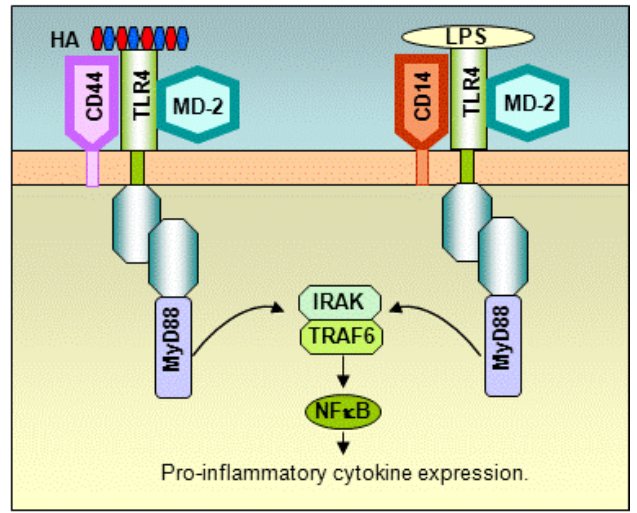
FIGURE 3. Comparable TLR4 signalling of HA and LPS. Adapted from Jiang et